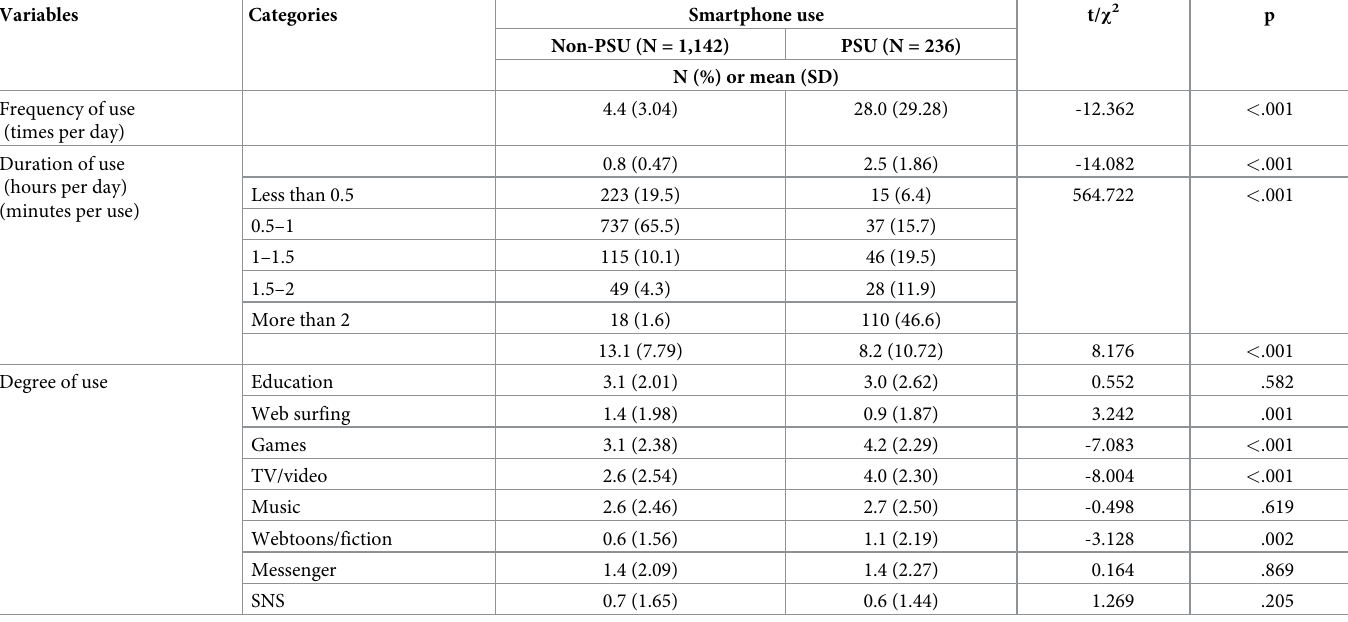
Table 2. Differences between non-PSU and PSU in smartphone use patterns (N =